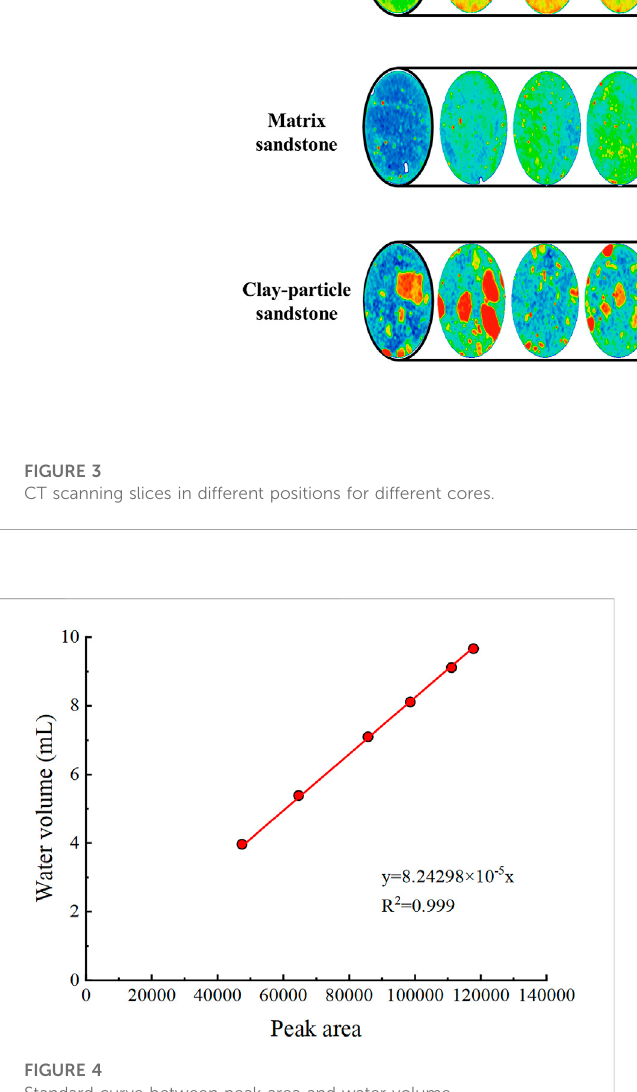
T 2 spectrums for water-saturated